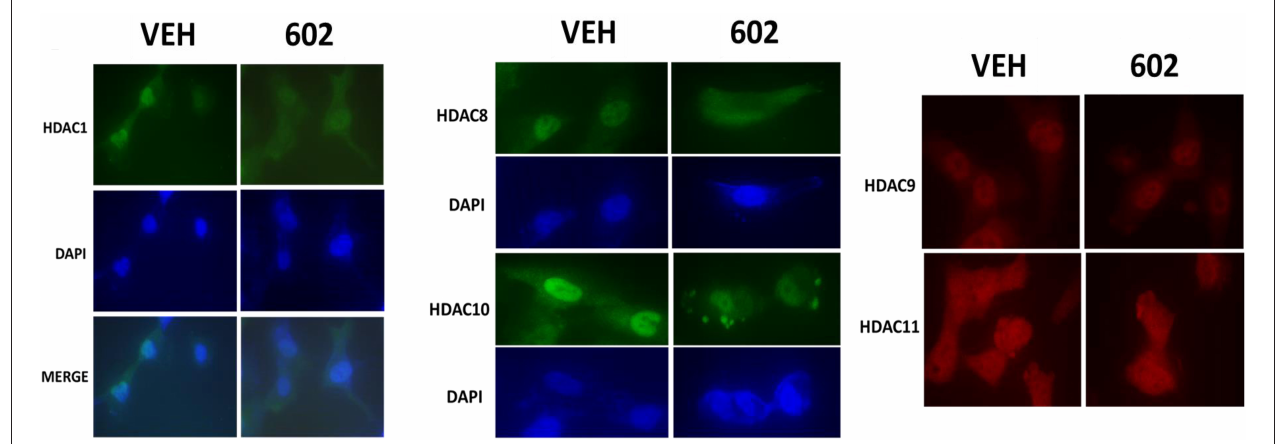
FIGURE 10 | GZ17-6.02 causes some HDACs to leave the nucleus; some to enter the nucleus and some do not move. HT1080 cells were transfected with a scrambled siRNA (siSCR) or with an siRNA to knock down the expression of AMPK α . Twenty-four hour afterwards, cells treated with vehicle control or with